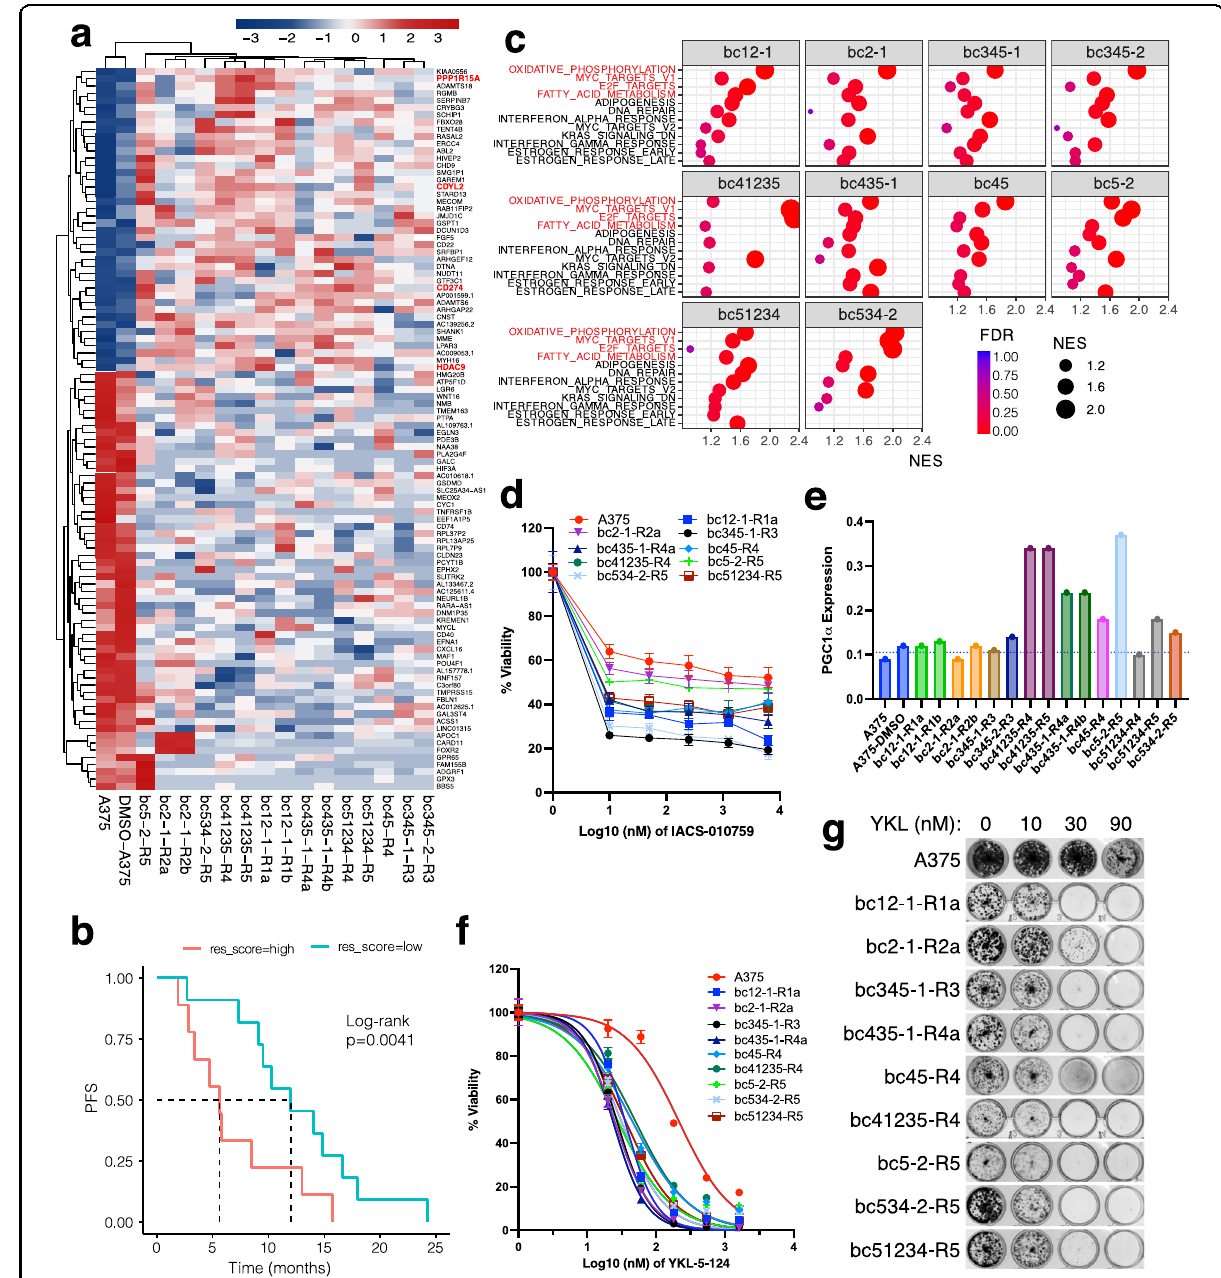
Fig. 6 Identi fi cation of potential common transcriptional dependencies of BRAFi-resistant clones. a Heatmap comparing the gene expression of controls (parental control and parallel control) and the PLX-resistant clones. Top 100 DEGs were shown. Genes that consistently up- and down-regulated in all captured clones were highlighted in red and blue, respectively. b Kaplan – Meier curves for PFS of patients from a published cohort 54 with high or low resistant gene signature score (res_score). The dashed lines indicate median PFS. c Dot plot showing the comparison of gene set enrichments from each captured lineage, only pathways enriched (FDR <0.25) in at least fi ve lineages are shown. Dots represent term enrichment with color coding from red (lowest FDR) to blue (highest FDR). The sizes of the dots represent the NES value, which is also the x -axis value for better spacing of dots. The commonly enriched pathways are highlighted in red. d Cell viability curves of the captured clones in response to an oxidative phosphorylation inhibitor IACS-010759. e Bar chart showing PGC1 α expression (FPKM value) of parental A375, parallel A375 control cells and captured clones. The blue dashed line indicates the average PGC1 α expression of control cells. f Cell viability curves of the captured clones in response to an E2F targets inhibitor YKL-5-124. g Colony formation assay of cells treated with the indicated drugs. Representative image of three independent